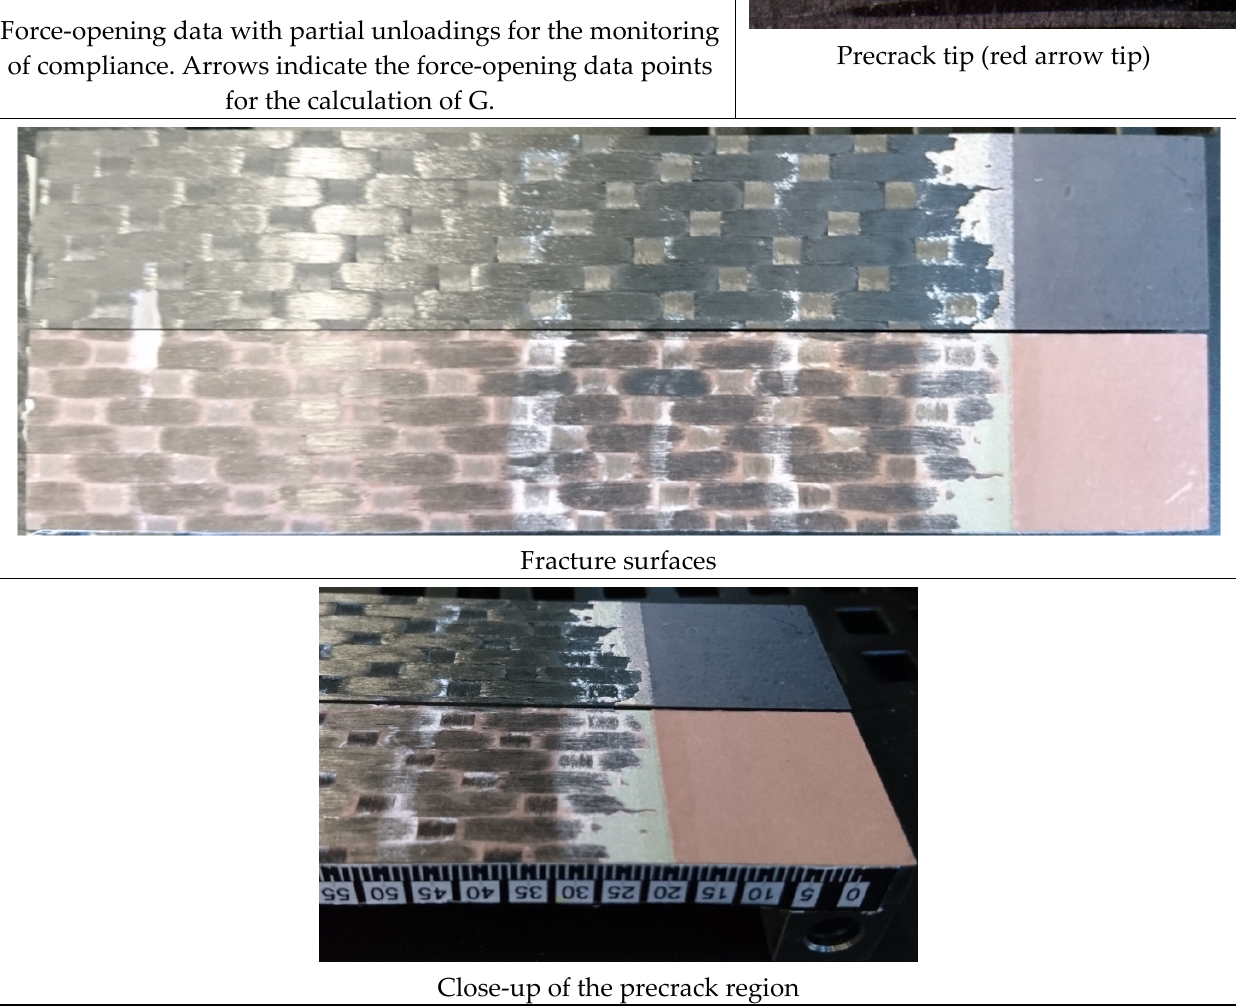
Figure 18. Results of the test on specimen DCB_9323_02.